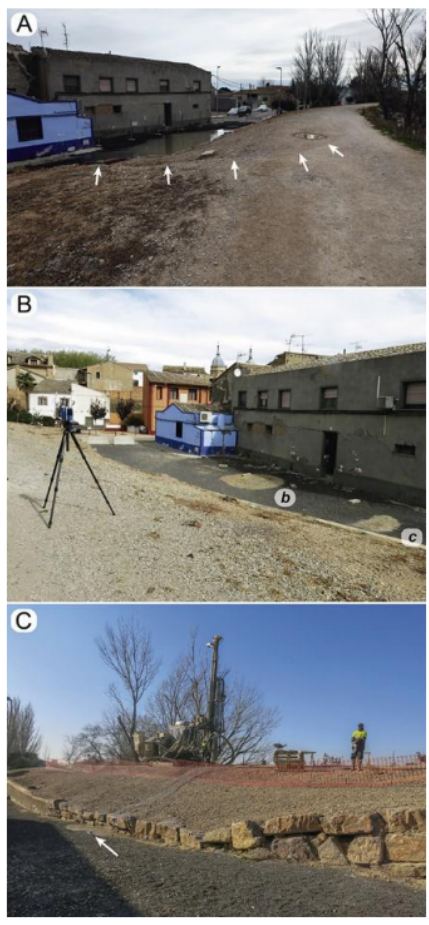
Figure 3. Images of the Alcal á sinkhole site taken at different dates. ( A ) Photograph taken on 2 March 2015, during the February–April Ebro River flood. The water stage in the river (right) is well above ground surface in the village, and water from the river flowed under pressure through and beneath the dike, flooding the sinkhole (left). The arrows point to an arcuate scarp-fissure developed in the dike. Note the cracking in the buildings. ( B ) Photograph taken on 5 October 2015, showing small collapse sinkholes (b and c) filled with lighter deposits. Note the cracking in the buildings. A laser scanner is to the left of the image. ( C ) Photograph taken on 1 December 2015 during the injection of polyurethane resin. The dike is affected by conspicuous sagging subsidence. The arrow points to borehole S-6, whose case protrudes above the ground